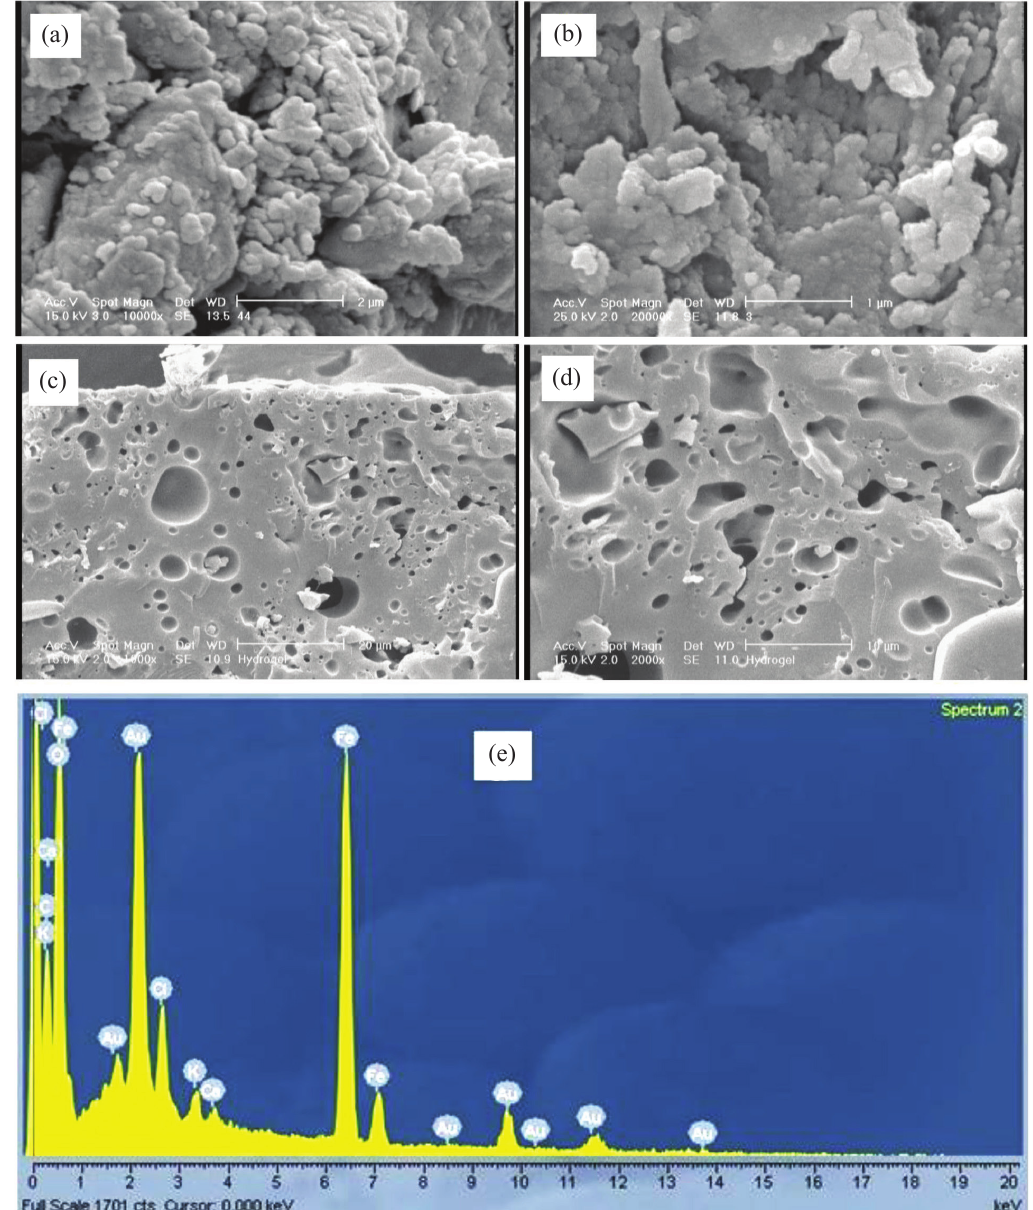
Fig. 3 – SEM images of poly(AA-co-AM)/Fe different magnification. The EDS spectra of MHN adsorbent